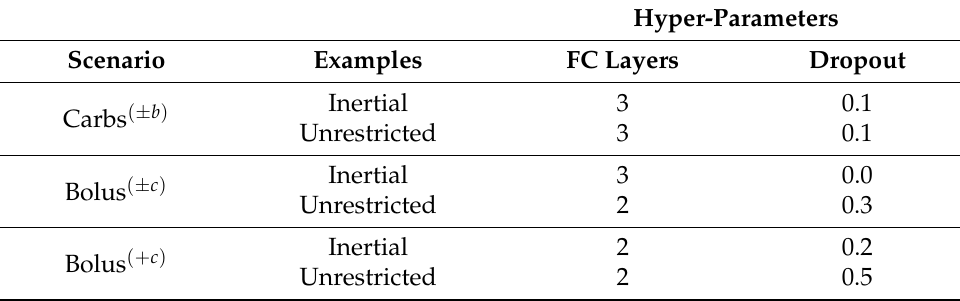
Table 9. Tuned hyper-parameters for the LSTM-based models.